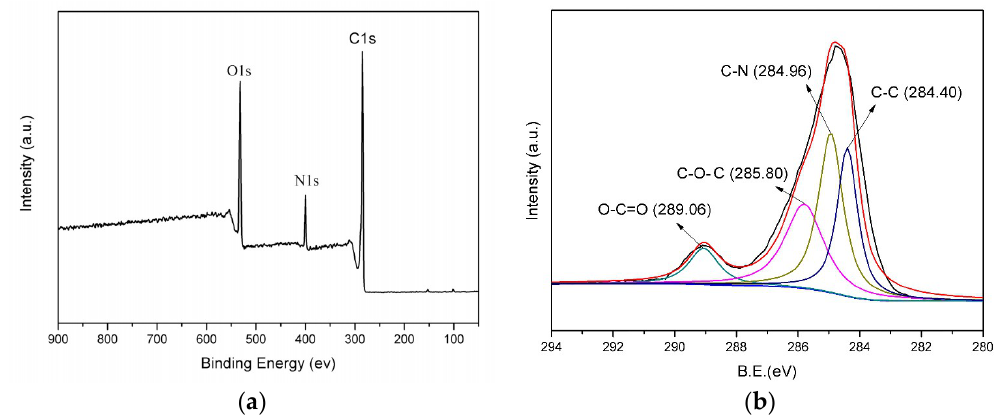
Figure 4. ( a ) The X-ray photoelectron spectroscopy (XPS) spectra of FCMSs; ( b ) The C1s spectra of FCMSs.